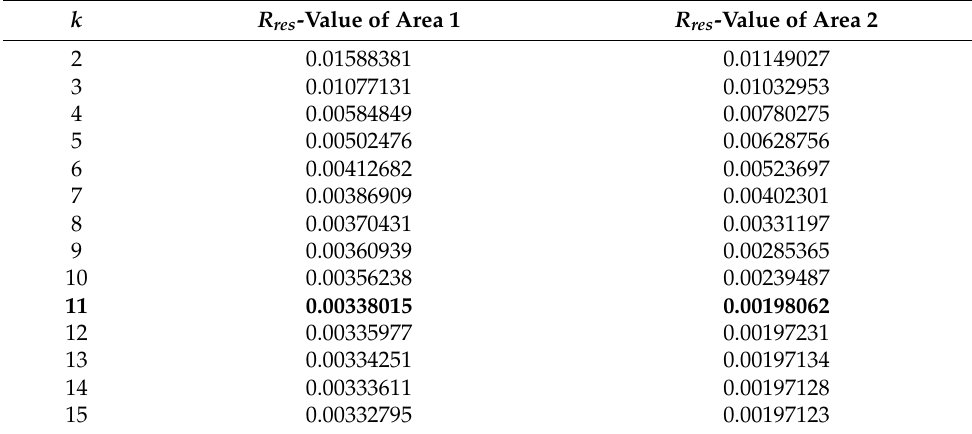
Table 3. R res -values corresponding to different k